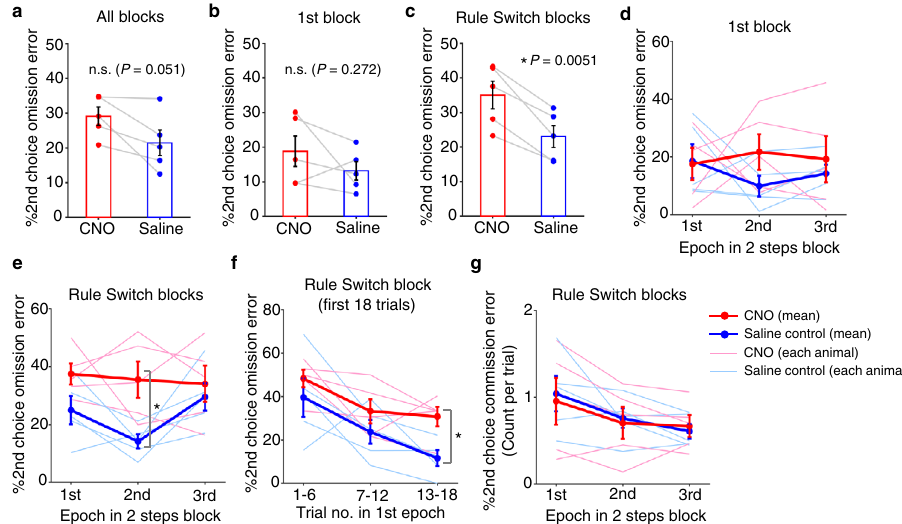
Fig. 4 | Chemogenetic silencing of ACC neuronal terminals in M2 disrupted animals ’ choiceperformance.a Groupresultof2ndchoiceperformancein2steps conditionwithalocalinfusionofeithersalineorCNOsolution. b Sameasin a ,but% 2nd choice omission error for trials in 1st block (i.e., non-rule switching block). c Sameasin a and b ,but%2ndchoiceomissionerrorfortrialsinRuleSwitch-blocks. d 2nd choice performance wasplotted separately for three epochs in the 1st block forsessionswithalocalinfusionofsalineorCNOsolution.Thickredandbluelines represent across-animal averages of CNO and saline conditions, respectively ( n =5 rats). Thin lines represent individual animals. 1st, 2nd, and 3rd epochs correspond to 1 – 18th, 19 – 36th, and 37 – 55th trials. Neither CNO dose nor epoch in 2 steps rule block showed a main effect ( P >0.2 for CNO dose and P >0.9 for epoch). e Same format as in d , but for Rule Switch-blocks. CNO dose showed a signi fi cant main effect ( P =0.00402, F 1,26 =9,969) while epoch did not ( P >0.3). Post hoc